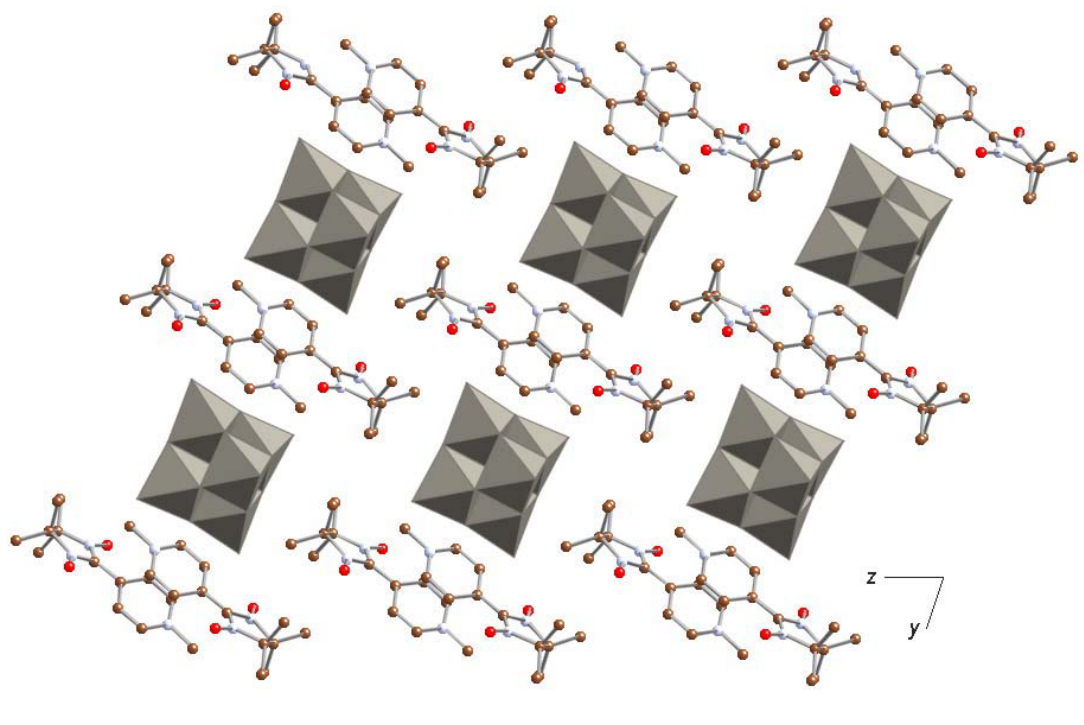
Figure 1. Projection of the crystal structure of 1 onto the bc